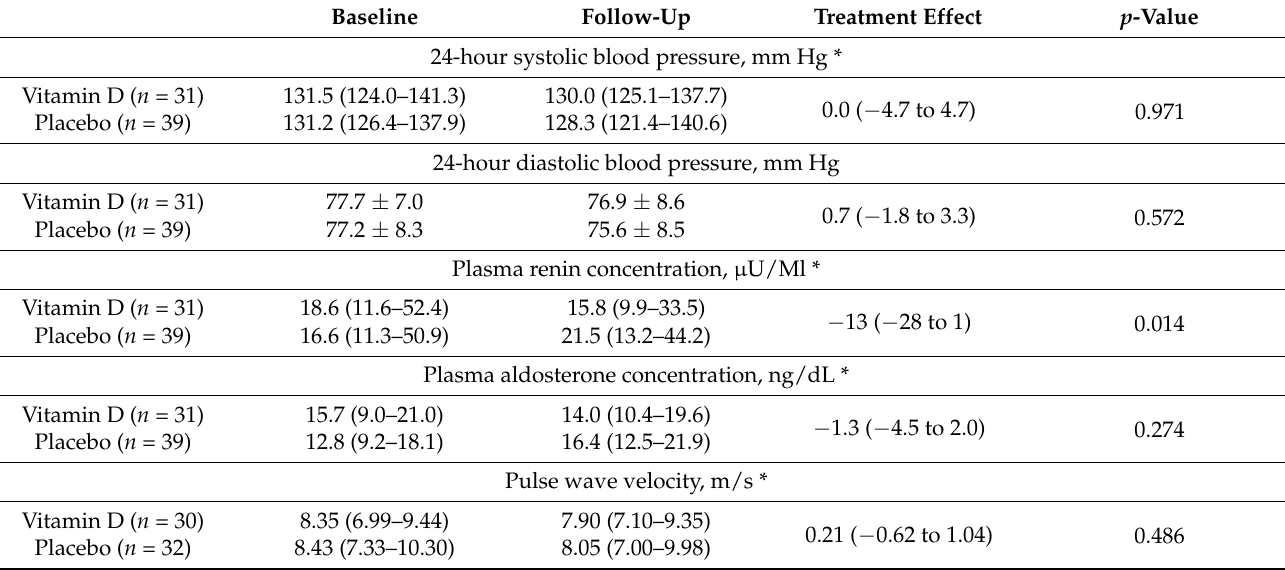
Table 2. Outcome variables at baseline and follow-up and treatment effects in 70 study participants with 25(OH)D < 20 ng/mL who completed the trial (of 75 participants with 25(OH)D < 20 ng/mL who had initially been